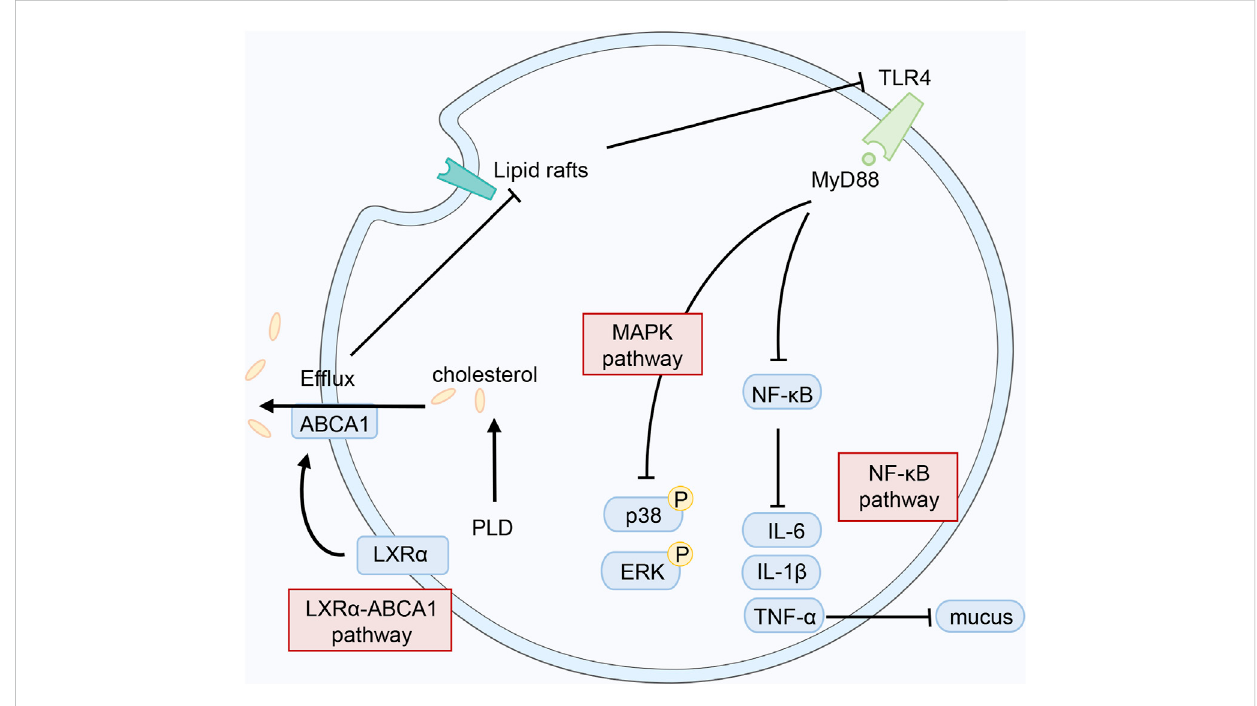
FIGURE 3 Possible mechanisms of PLD in anti-in fl ammatory